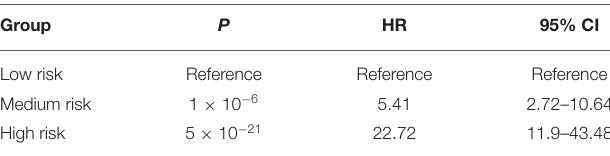
TABLE 7 | Prognostic analysis for composite risk score using Cox proportional hazards regression model. Group